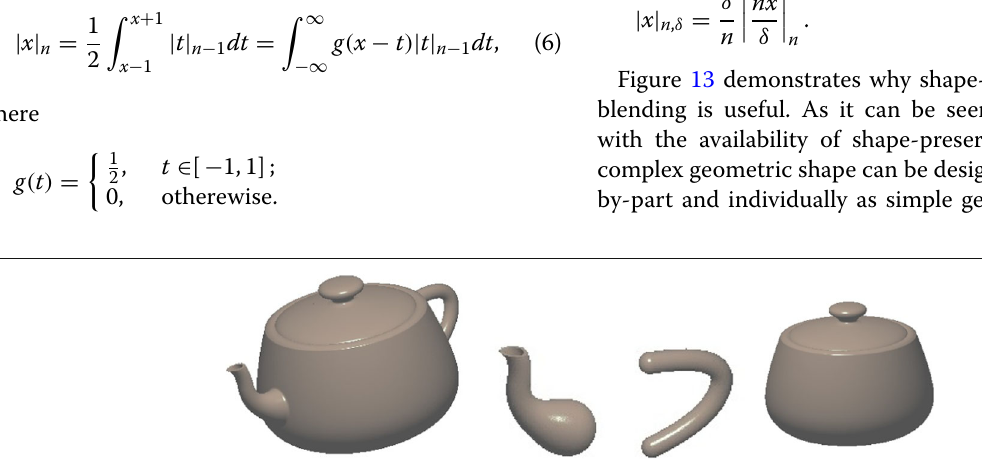
Fig. 13 Shape-preserving smooth blending allows to sub-divide a relatively complex object into simpler components, each of which can be designed individually. These individually designed components can then be combined together smoothly by using a smooth shape-preserving implicit function-blending